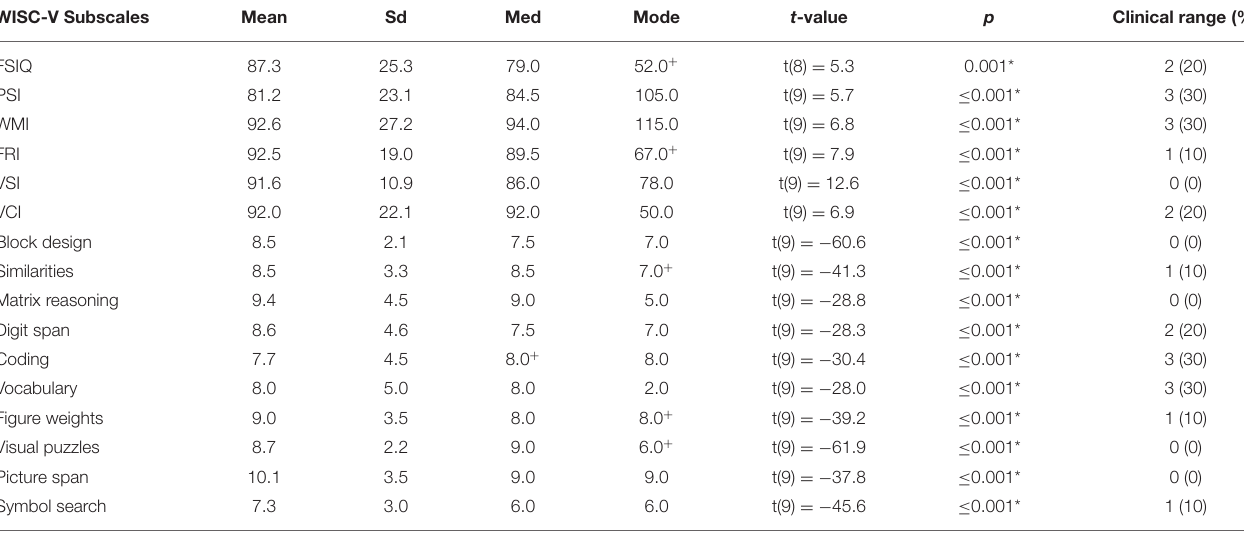
TABLE 2 | Cognitive profile of children and adolescents who completed the WISC-V ( n = 10), compared to norms. WISC-V Subscales Mean Sd Med Mode t -value p Clinical range (%) FSIQ